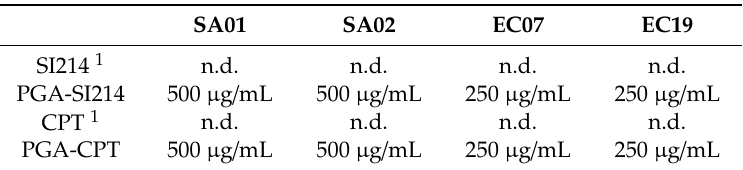
Table 2. Minimum Inhibitory Concentration